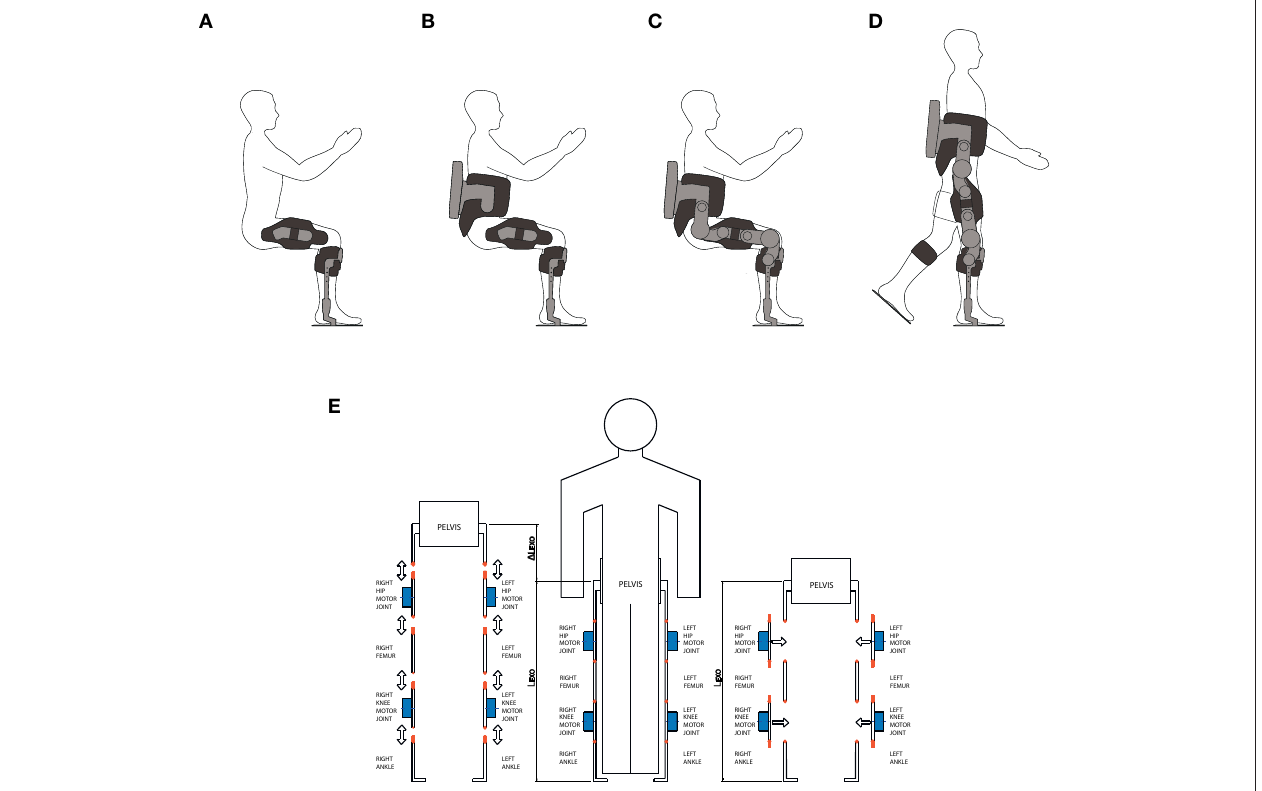
FIGURE 3 | The modularity design concept adopted in the development of the TWIN exoskeleton. (A,B) The user can freely wear the lighter and smaller parts of the exoskeleton before, after or between two exoskeleton sessions for ease of transportation and device management. (C,D) The user can wear the motor and battery modules as well when he needs to use the exoskeleton. (E) The lateral mounting modular design concept. Considering the in-line type of mounting shown in the left, donning requires additional space ( 1 LEXO ), in the limb direction. Because of this reason, unless the exoskeleton is mounted following a specific sequence (either bottom-up or top-down), this scenario may result in awkward donning operations. On the contrary, the adopted lateral mounting system does not require any additional space to be mounted and is free from donning sequence constraints.